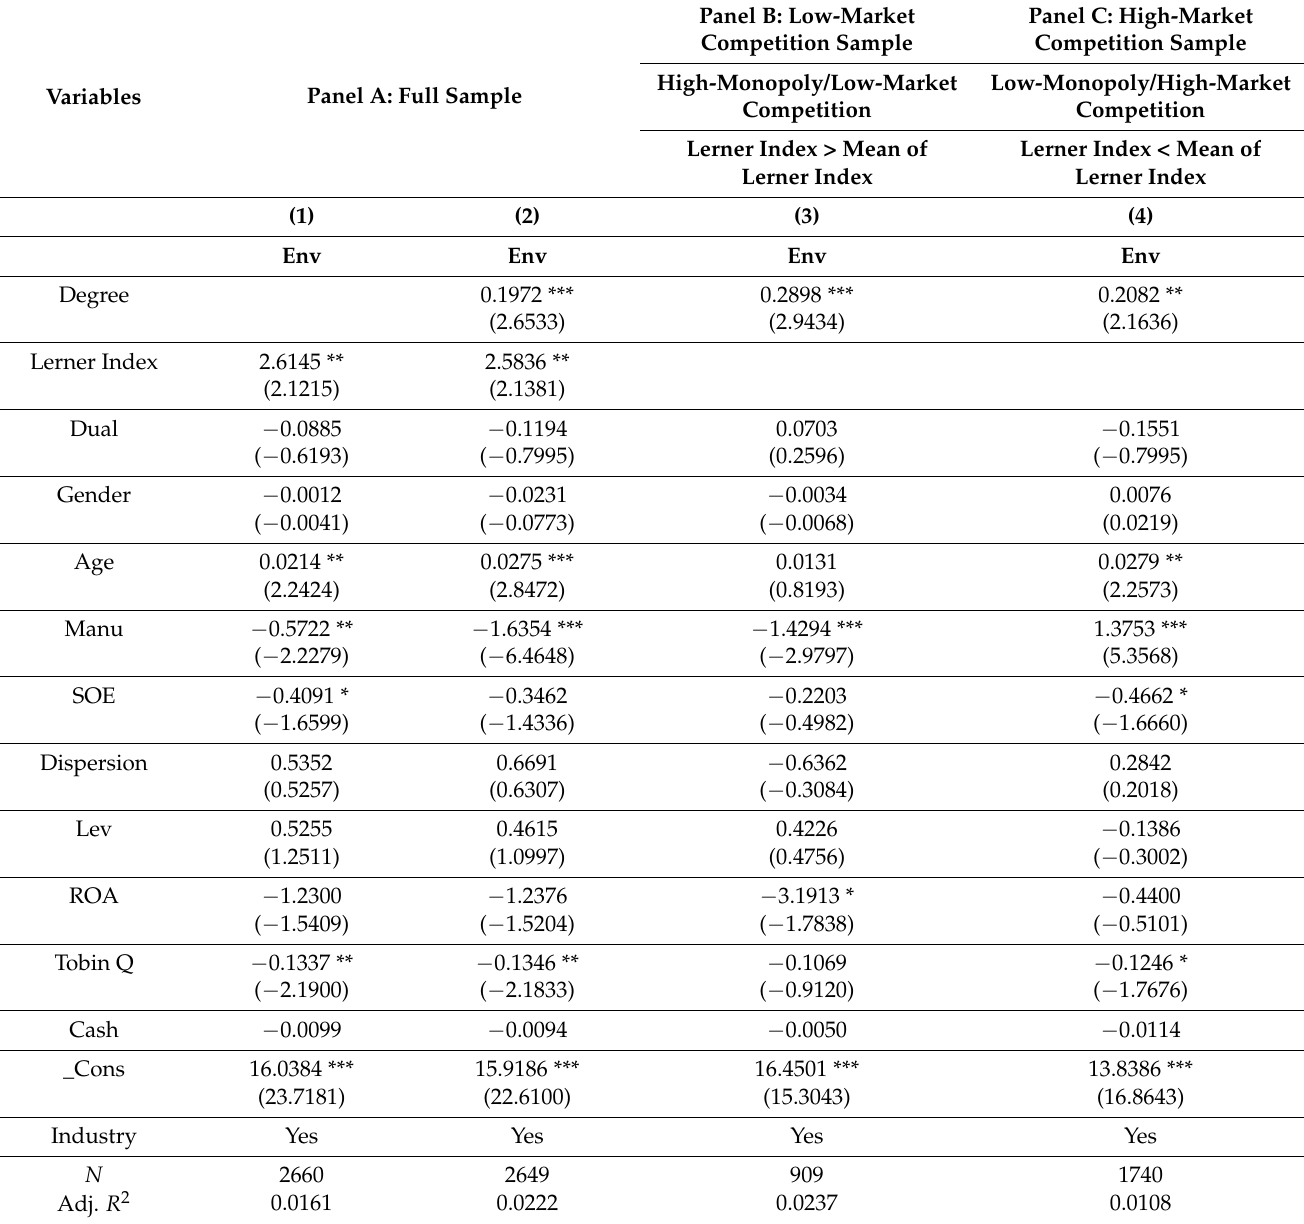
Table 9. Regression results: high-market competition and low-market